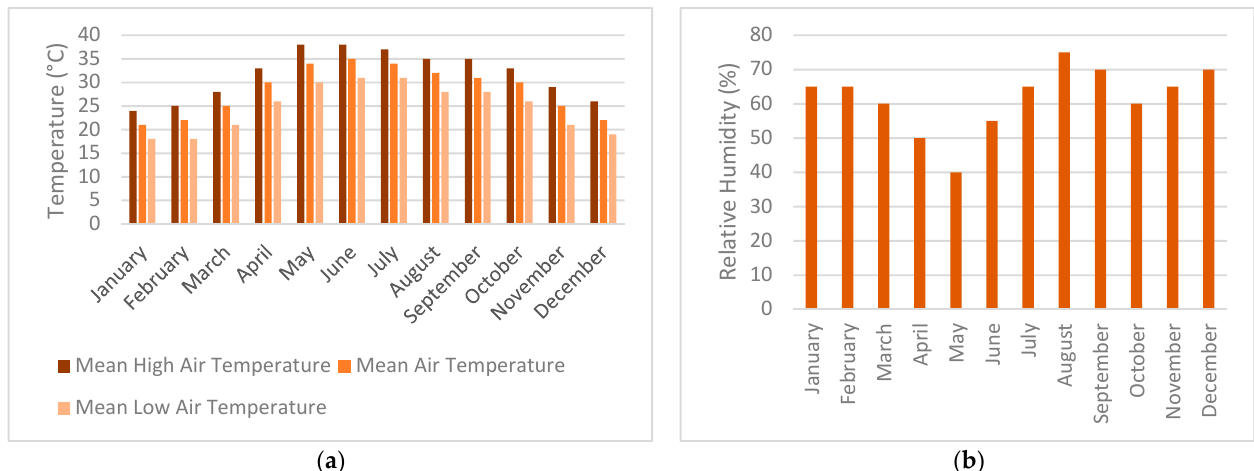
Figure 2. ( a ) Mean ambient air temperature in a typical year in Muscat, Oman. ( b ) Mean relative humidity in a typical year in Muscat, Oman.